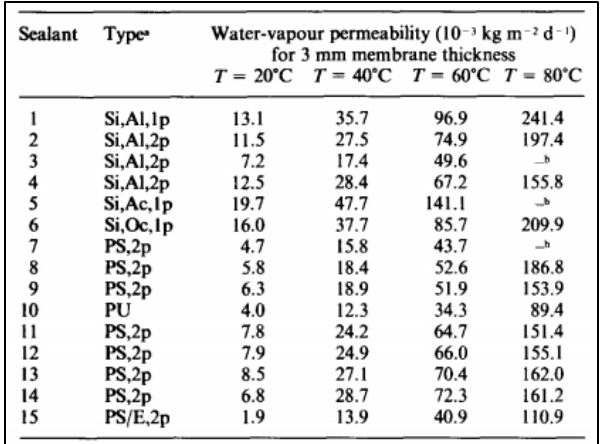
Figure 5. Water-vapor Permeability of Insulating Glass Sealants as a Function of Temperature [14].